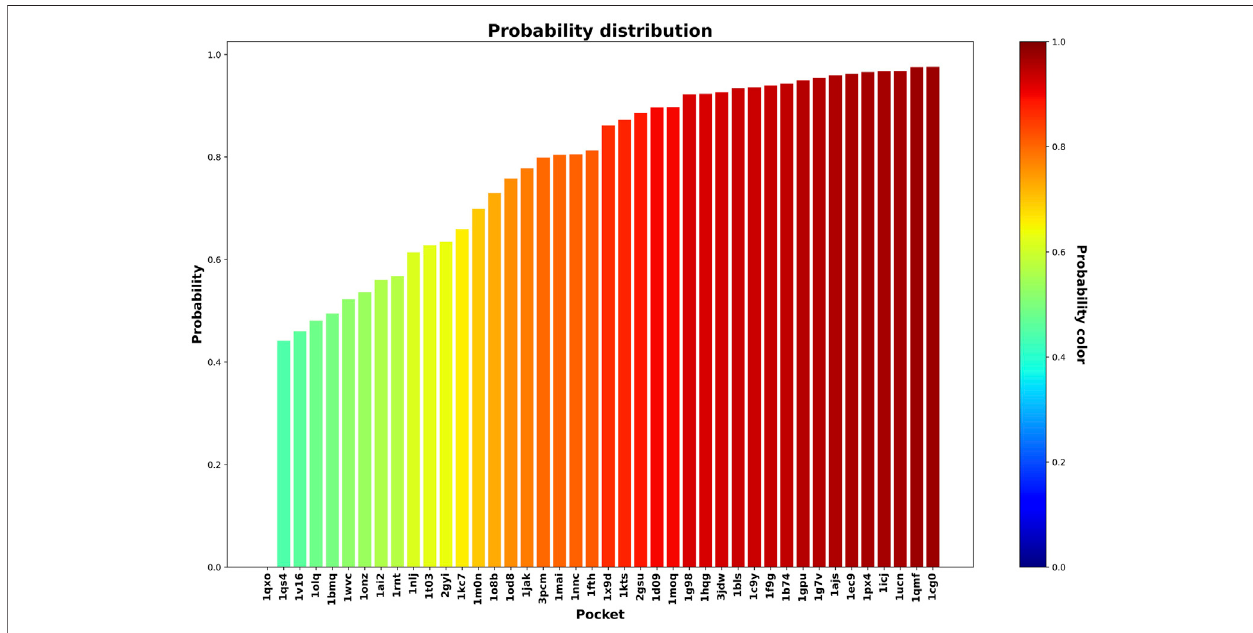
FIGURE 6 | Druggability prediction for the less druggable subset of the NRDLD dataset with the addition of hydrogen atoms. For each protein binding site (the x -axis), we predicted its druggability probability (the y -axis and color of the bar).